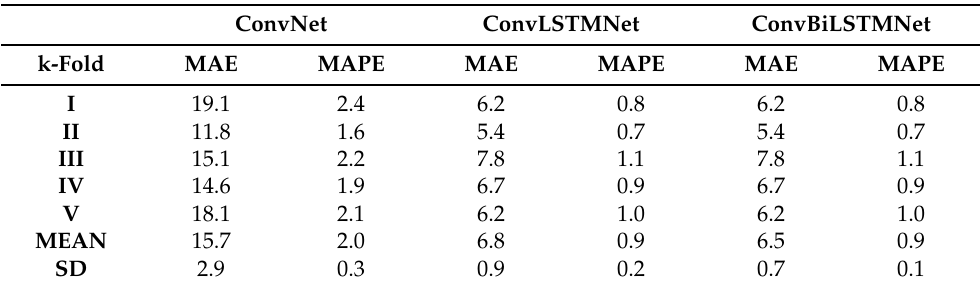
Table 3. The comparison of three NN architectures according to MAE/MAPE metrics. The usage of bidirectional LSTM units gave an improved performance comparing to the ConvNet and the ConvLSTMNet . ConvNet ConvLSTMNet